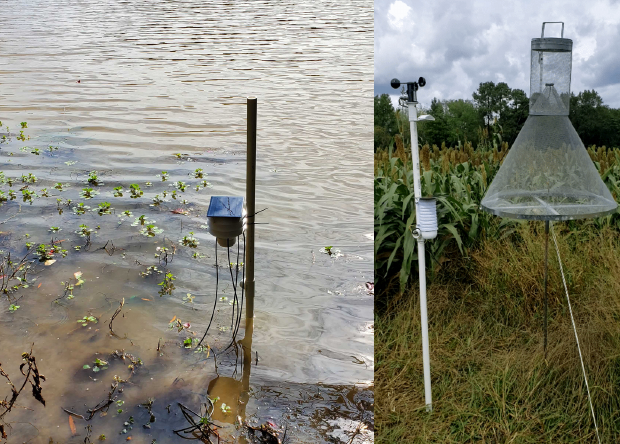
Figure 1. The system as deployed to measure bivalve activity ( left ) and moth activity ( right